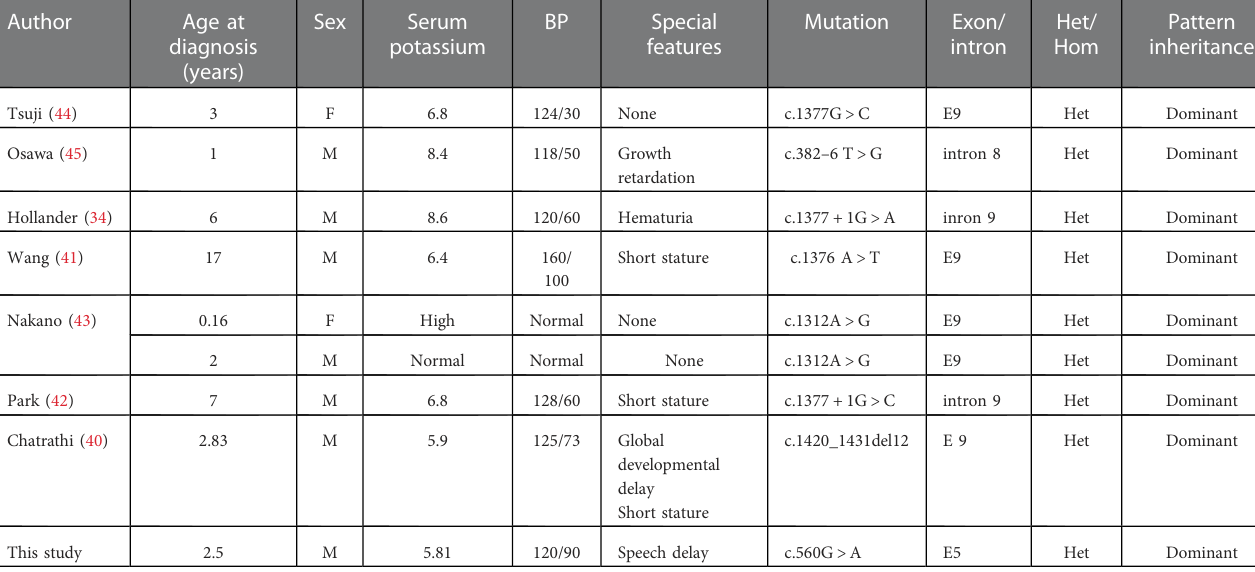
TABLE 4 Review of the characteristics of PHA2 patients with CUL3 gene